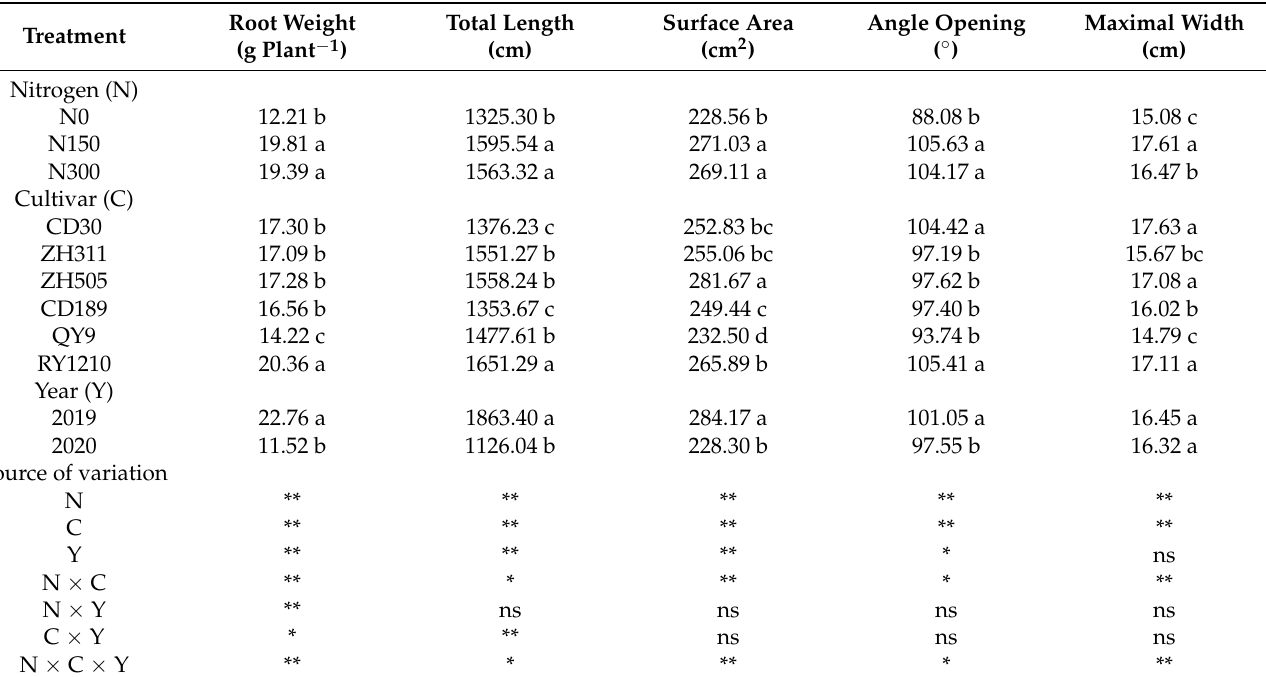
Table 4. Evaluation of root system traits of six cultivars under three nitrogen (N)